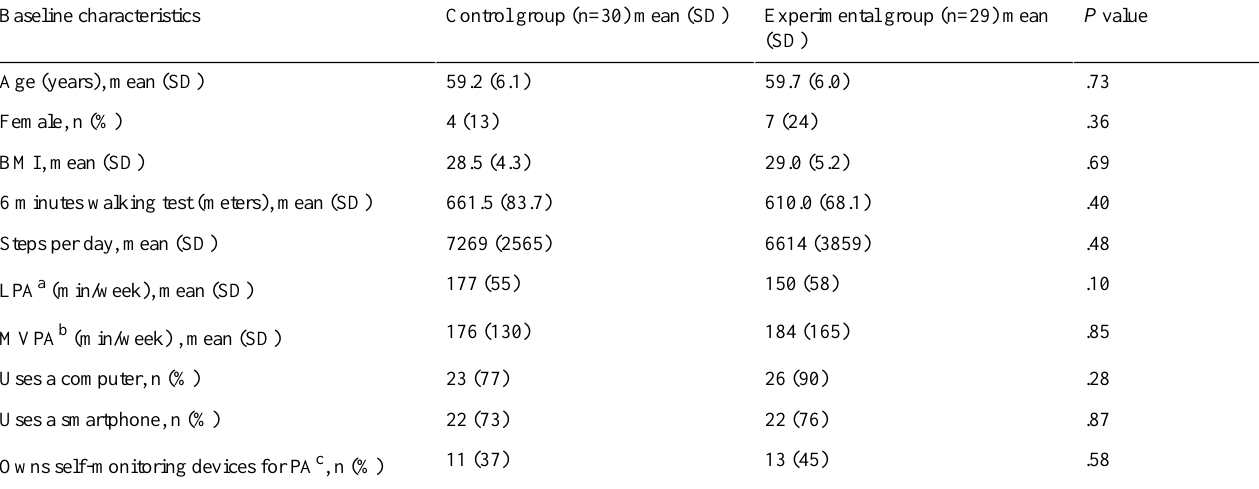
Table 1. Baseline characteristics in the conventional cardiac rehabilitation control group and the additional distance technology intervention experimental